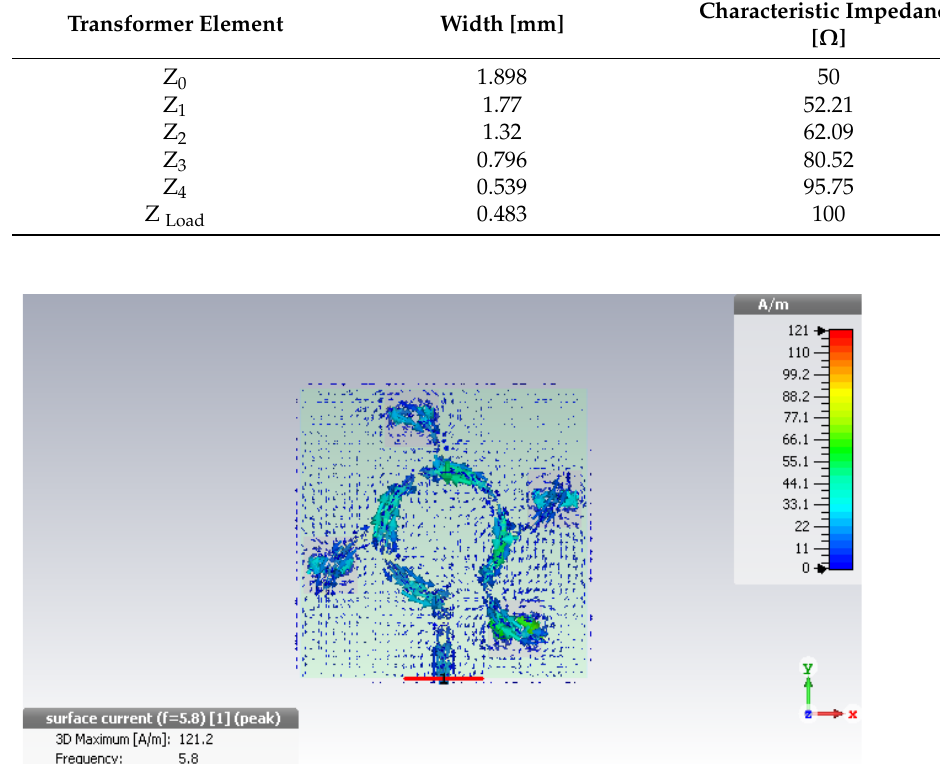
Figure 5. Current flow through the feeding array network.